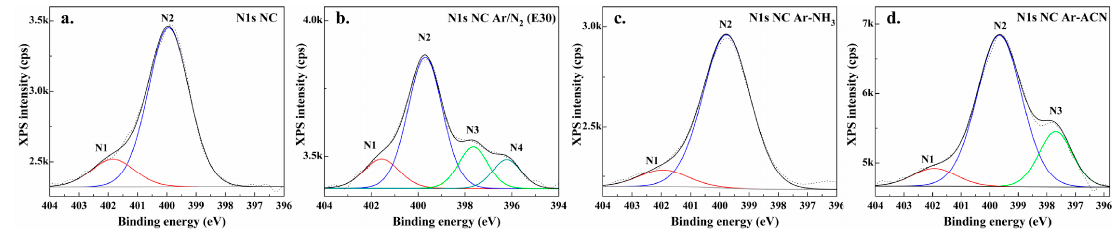
Figure 9. High resolution N1s spectra with deconvolution (different colored N1–N4 components) of